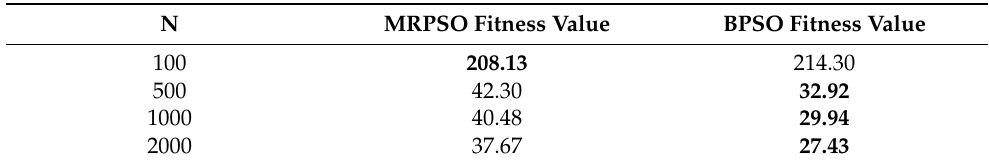
Table 9. Mean of the particle best-fit values in MRPSO and BPSO on f 4 . The bold numbers refers to the better